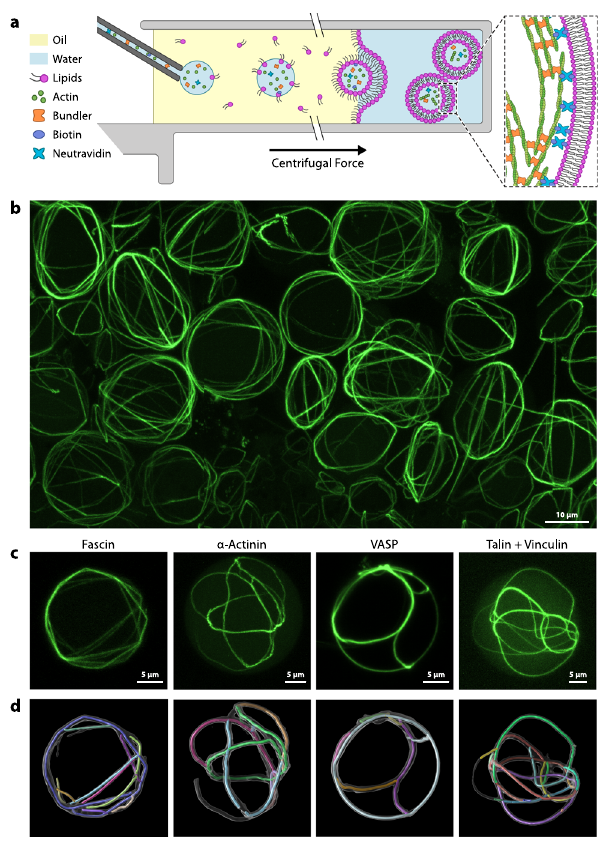
Fig. 1 Encapsulation of bundled actin in giant unilamellar vesicles. a Schematic depiction of the vesicle generation process. The aqueous protein solution is injected into a rotating chamber through a glass